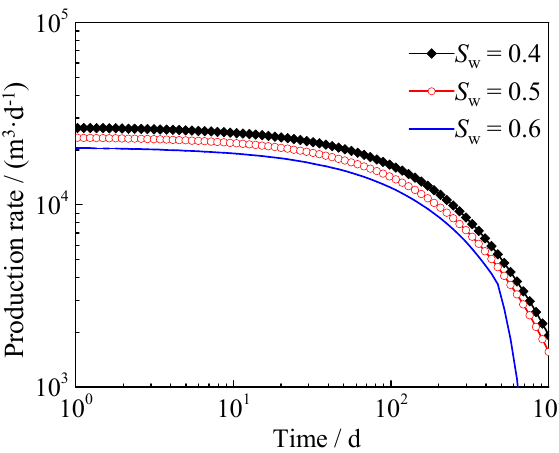
Figure 10. Influence of water saturation in stimulated reservoir volume (SRV) on the gas flow rate in a shale gas reservoir with high water saturation.